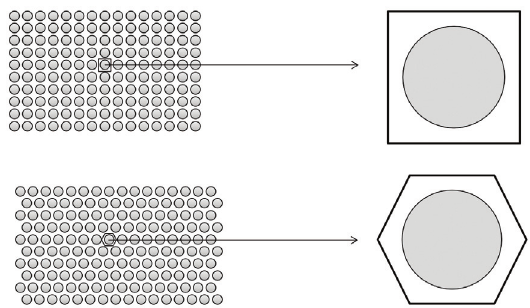
Figure 5. Unidirectional two-phase composite with periodic square and hexagonal distributions of